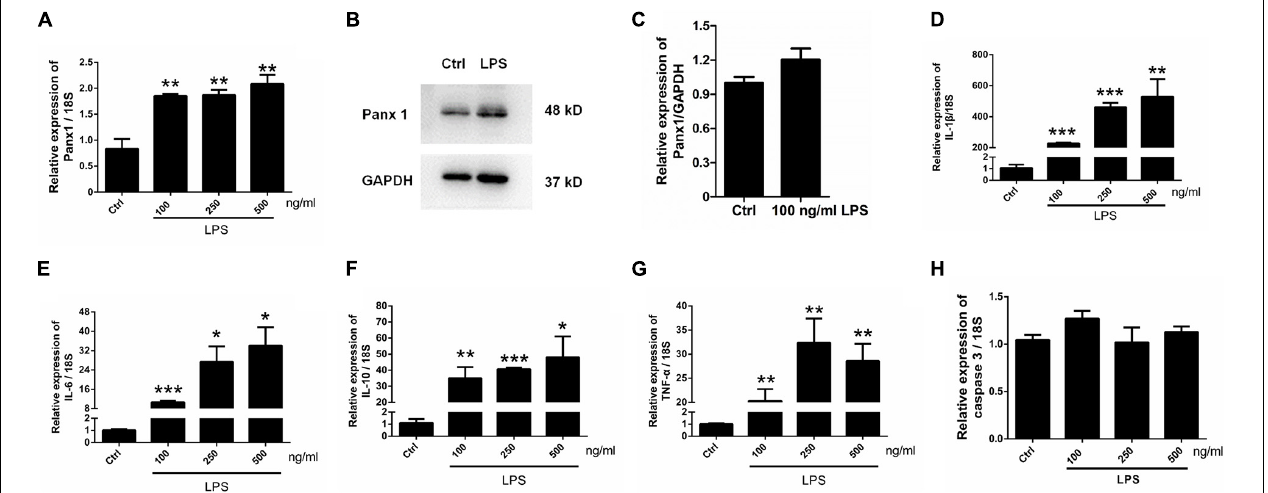
FIGURE 4 | Panx 1 and inflammatory cytokine expression in LPS-treated astrocytes. mRNA expression of Panx 1 (A) and the selected inflammatory cytokine IL-1 β (D) , IL-6 (E) , IL-10 (F) , TNF- α (G) and caspase 3 (H) were measured by qPCR assay. Primary cultured astrocytes were treated with LPS at different doses (100, 250, and 500 ng/ml) for 24 h. The levels were displayed as percentage of the control (the same volume of DMSO). The data were normalized to 18S mRNA levels. Western blot analysis of Panx 1 expression (B,C) after treatment with 100 ng/ml LPS. Protein levels were quantified and normalized to GAPDH levels, n = 3. All data are mean ± SEM. Statistical comparison for (A,D–H) were performed using one-way ANOVA, following by Newman–Keuls Multiple Comparison Test, and for (C) using Student’s t -test. * p < 0.05, ** p < 0.01, *** p < 0.001 compared with the control group. Student’s t -test.